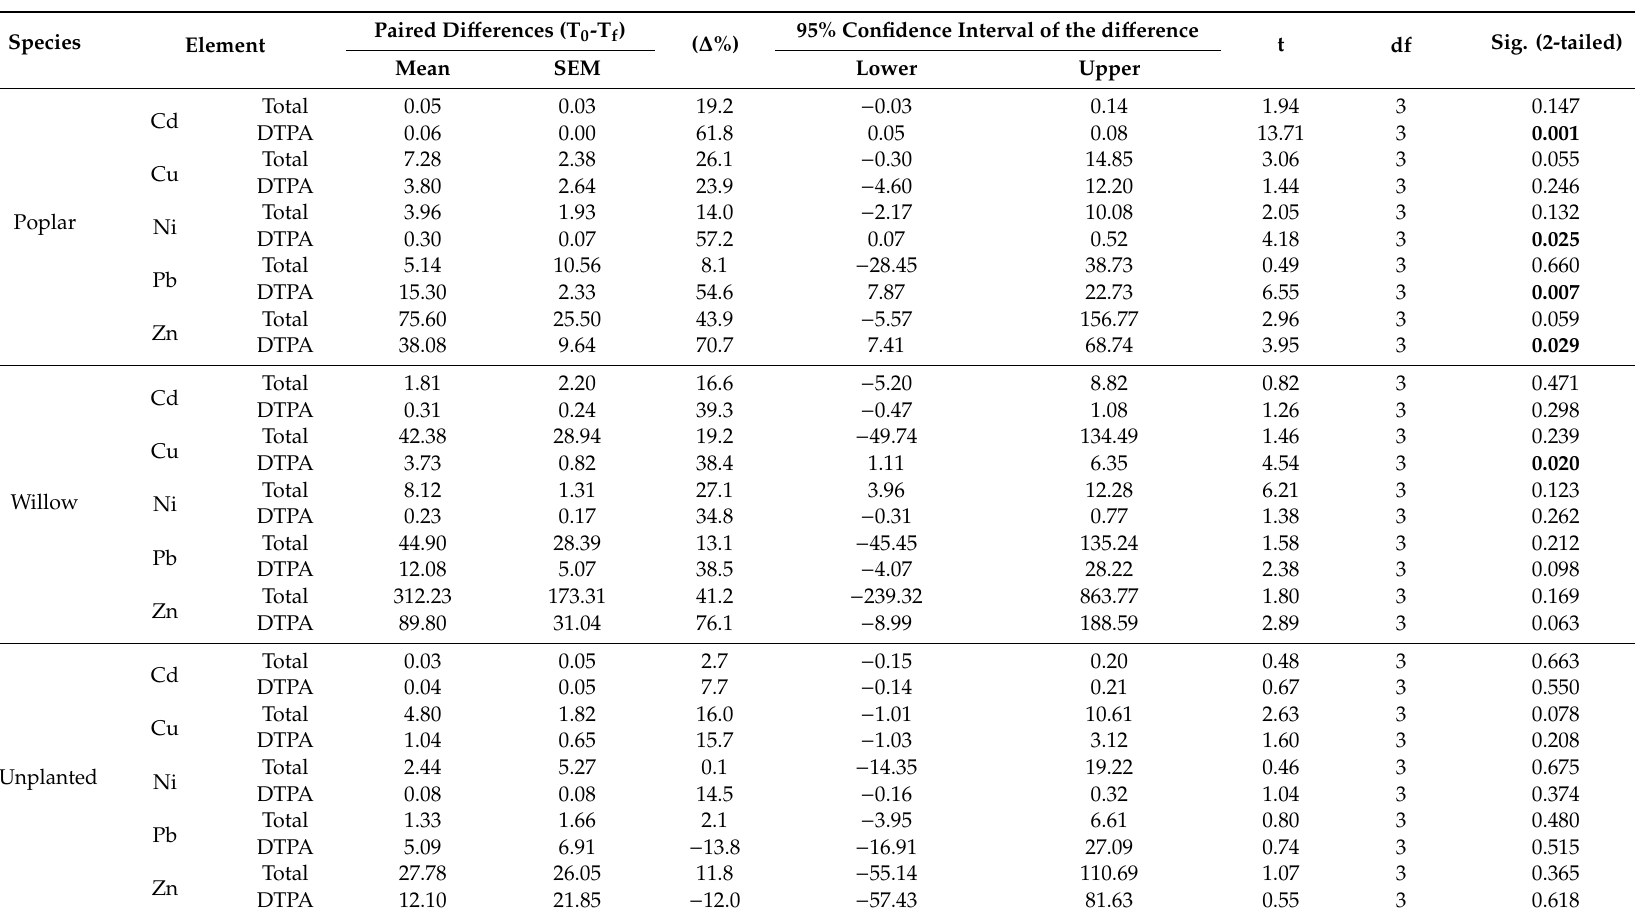
Table 3. Comparison between total and extractable trace element (TE) concentrations in soil at the beginning (T 0 = 2015) and the end (Tf = 2018) of the trial. Species